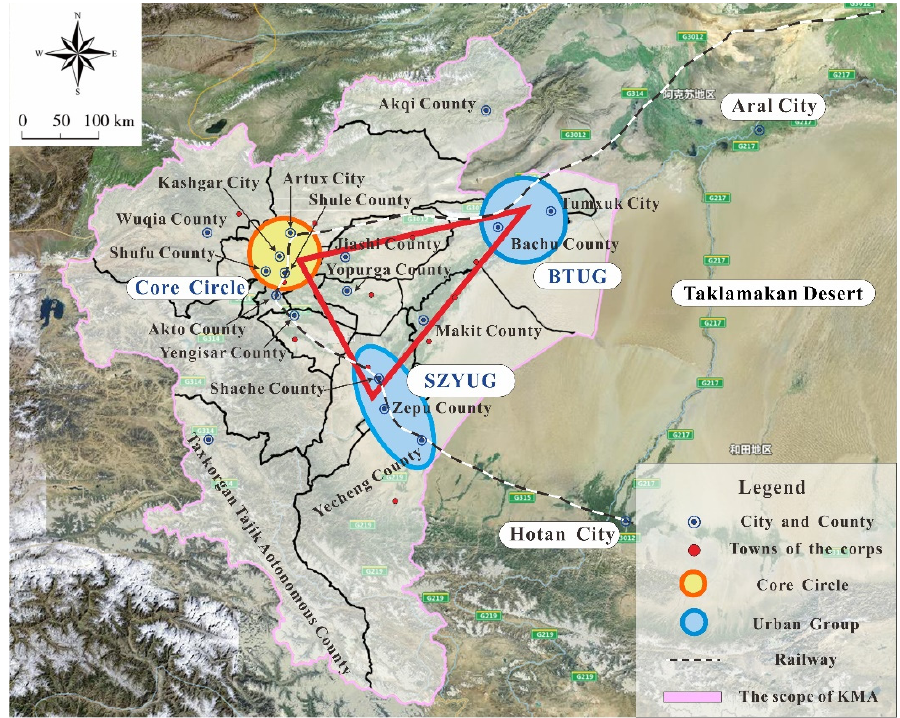
Figure 14. A spatial development pattern of KMA.